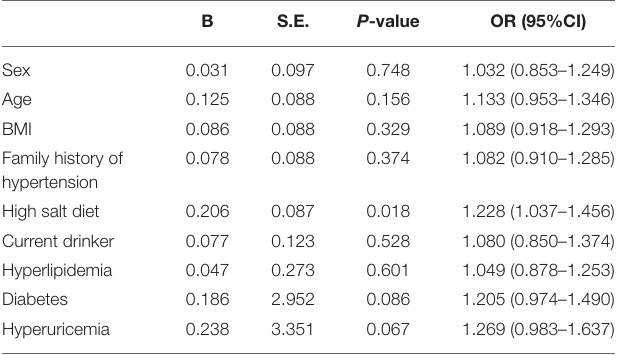
TABLE 2 | Analysis of factors associated with positive results of